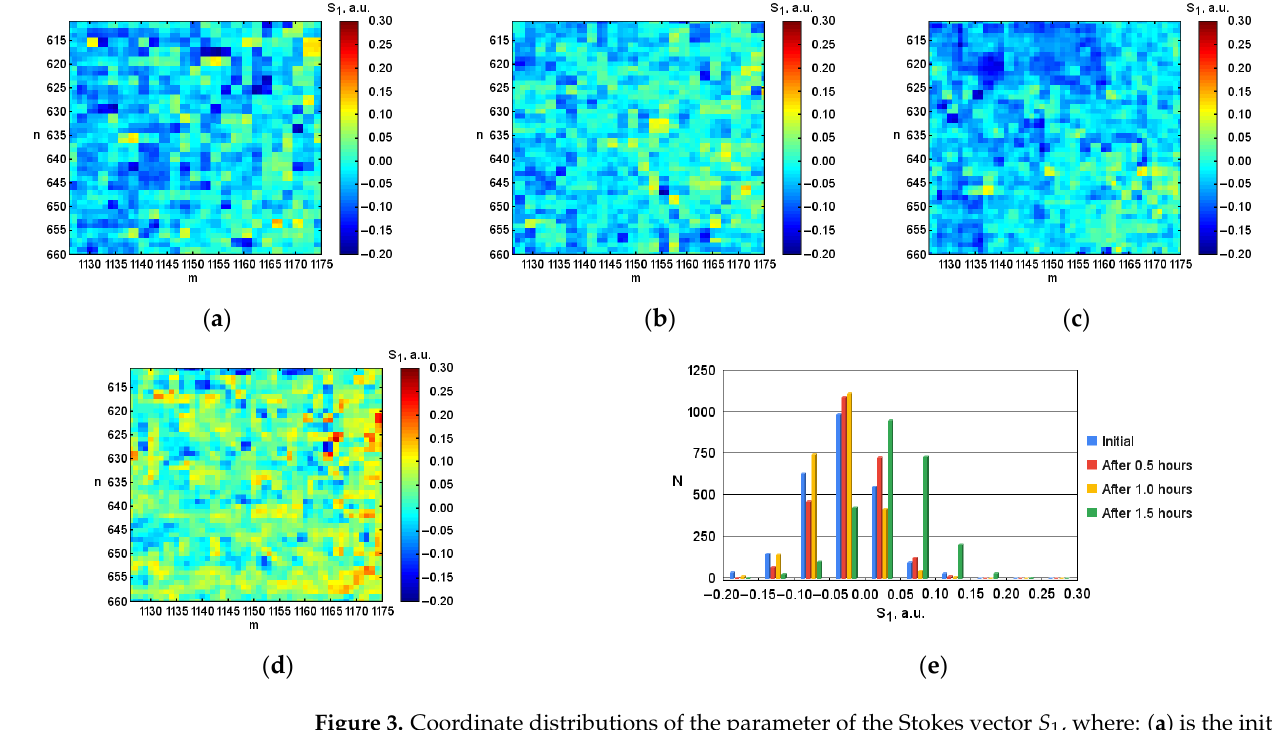
Figure 3. Coordinate distributions of the parameter of the Stokes vector S 1 , where: ( a ) is the initial hematocrit level; ( b ) is the hematocrit level after 0.5 h; ( c ) is after 1.0 h; ( d ) is after 1.5 h, and ( e ) the corresponding histograms of the object under investigation.